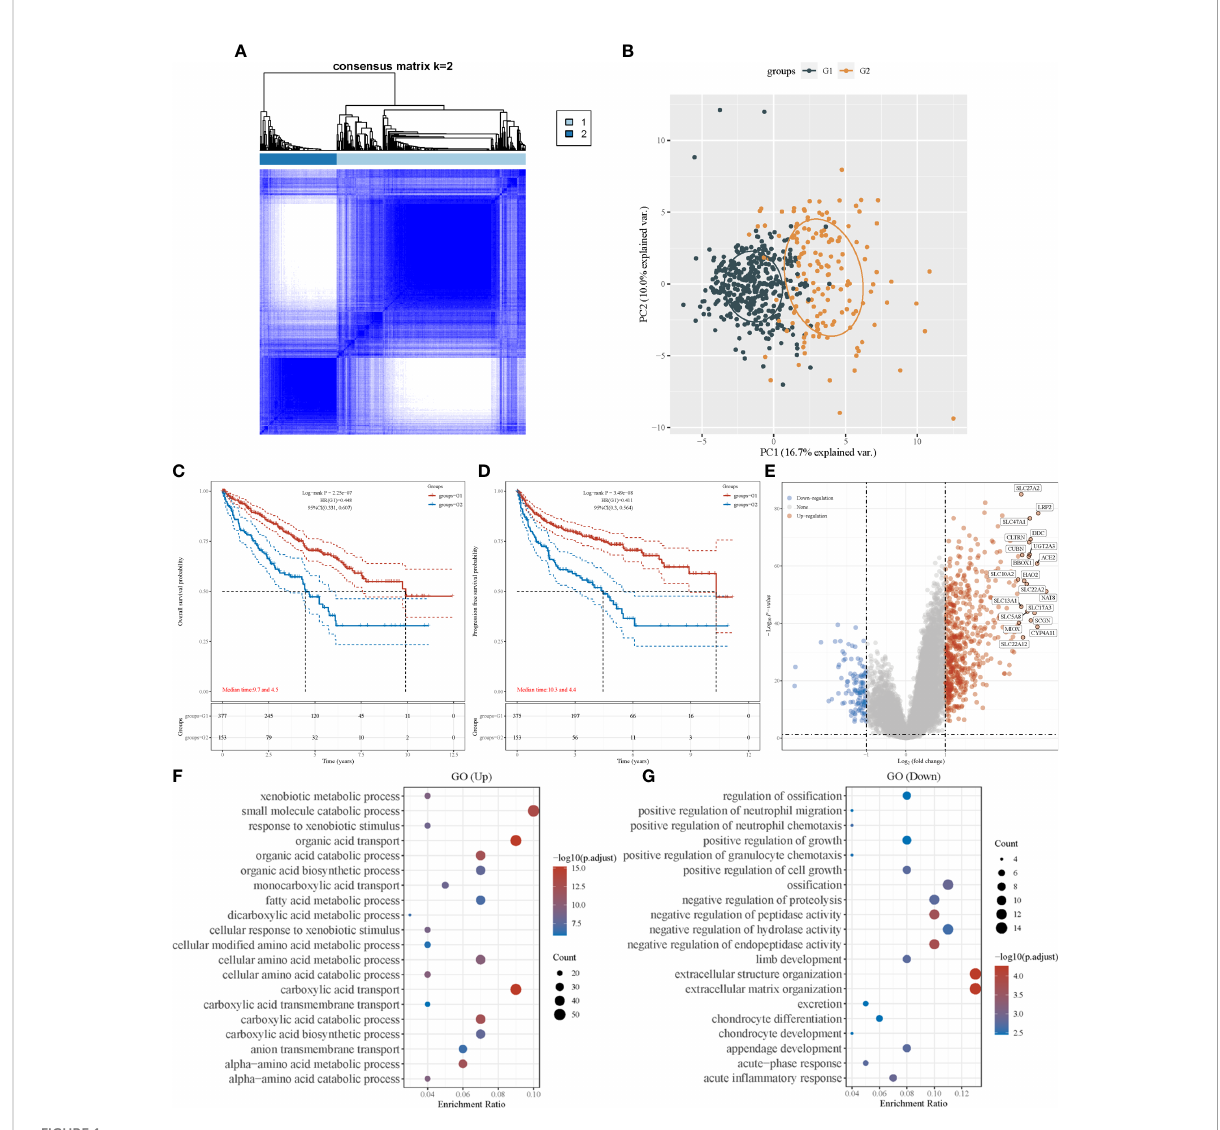
FIGURE 1 Consensus clustering analysis to identify the genomic subtype of ccRCC based on an amino acid metabolism-associated gene set. (A) Consensus clustering matrix of 530 samples from TCGA dataset for k=2. (B) PCA distinguishing patients ’ risk groups. Kaplan – Meier curve of overall survival (C) and progression free survival (D) of patients with ccRCC in two clusters. (E) Volcano plot of DEGs between two clusters with different metabolic statuses. The red and blue points represent up- and downregulated genes with statistical signi fi cance, respectively. (F) GO analysis of DEGs that were upregulated in cluster 1. (G) GO analysis of DEGs that were downregulated in cluster 1. PCA, principal component analysis; DEG, differentially expressed